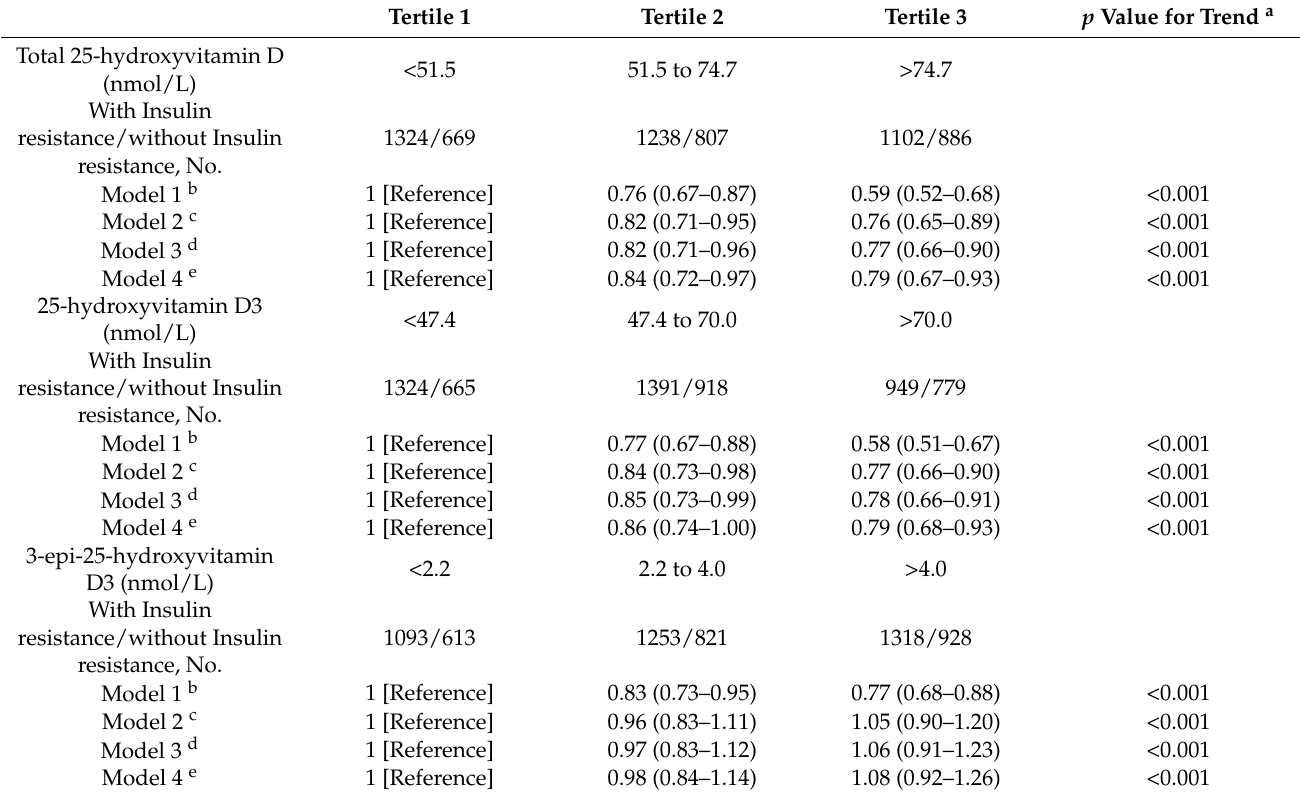
Table 3. Odds Ratio of Insulin resistance by 25-hydroxyvitamin D